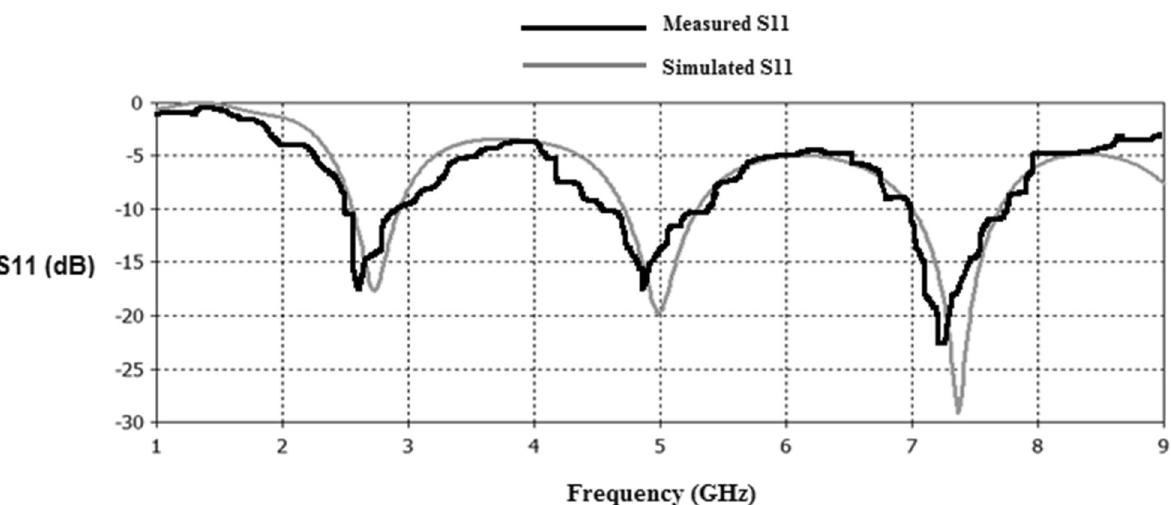
Figure 30. Simulated and measured S11 responses of